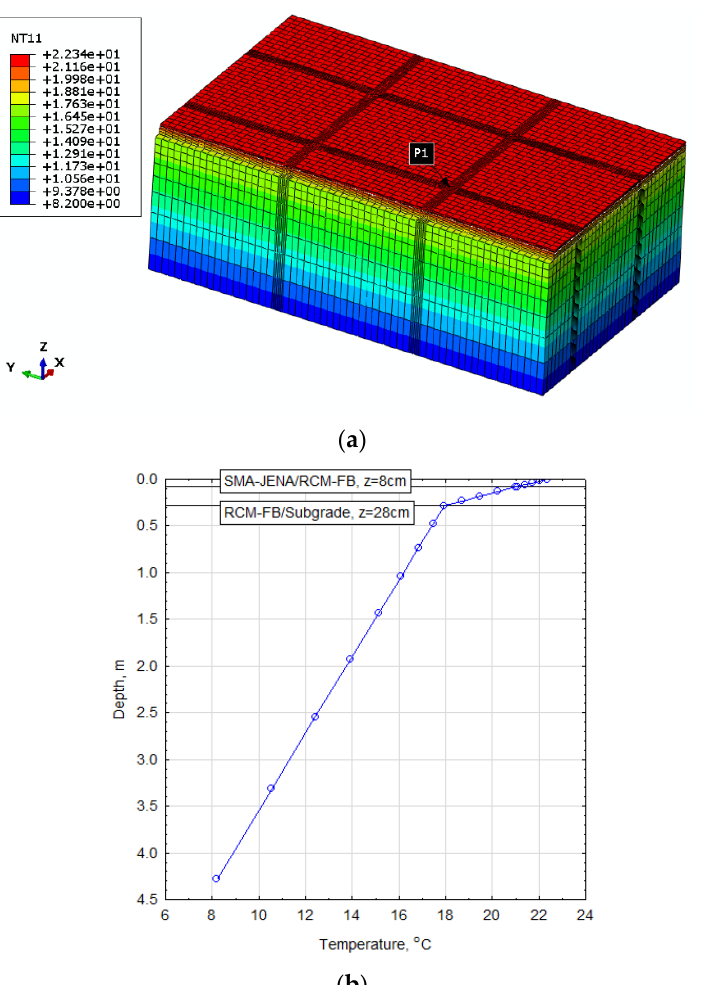
Figure 10. Temperature distribution in the cross-section of the road constructed with the CRM-FB_5C base: ( a ) 3D view of temperature distribution; ( b ) cross-section at point P1